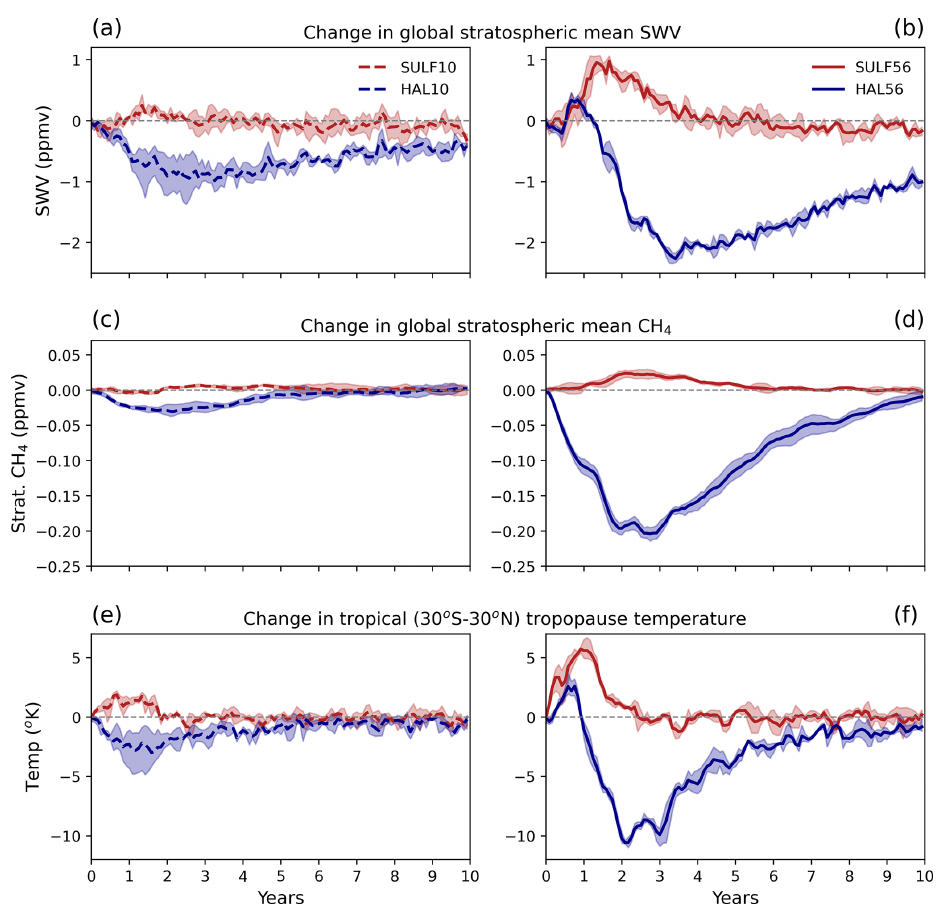
Figure 8. Evolution of global stratospheric mean water vapour anomalies (ppmv) in SULF10 and HAL10 (a) and in SULF56 and HAL56 (b) . Evolution of global stratospheric methane anomalies (ppmv) in SULF10 and HAL10 (c) and in SULF56 and HAL56 (d) . Evolution of tropical tropopause cold trap temperature anomaly averaged over 30 ◦ S–30 ◦ N and 15–20km in SULF10 and HAL10 (e) and in SULF56 and HAL56 (f) . Shading represents the ensemble